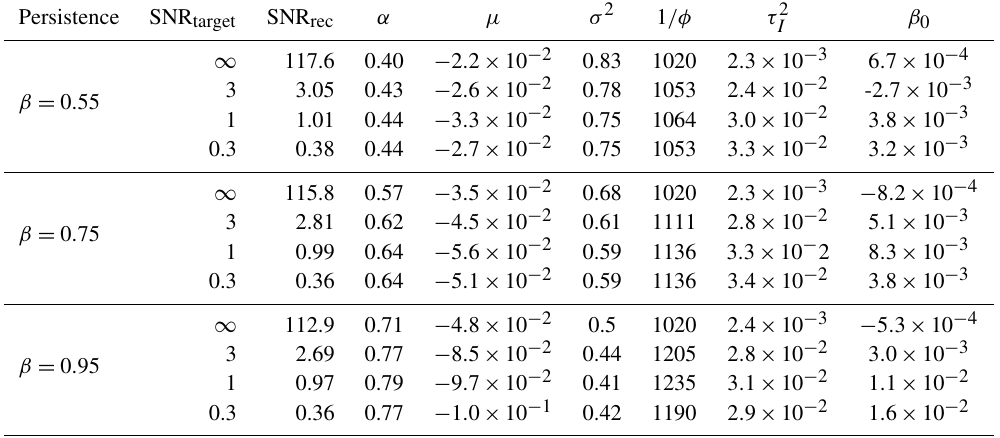
Table C3. Mean of posterior distribution for each parameter. Persistence SNR target